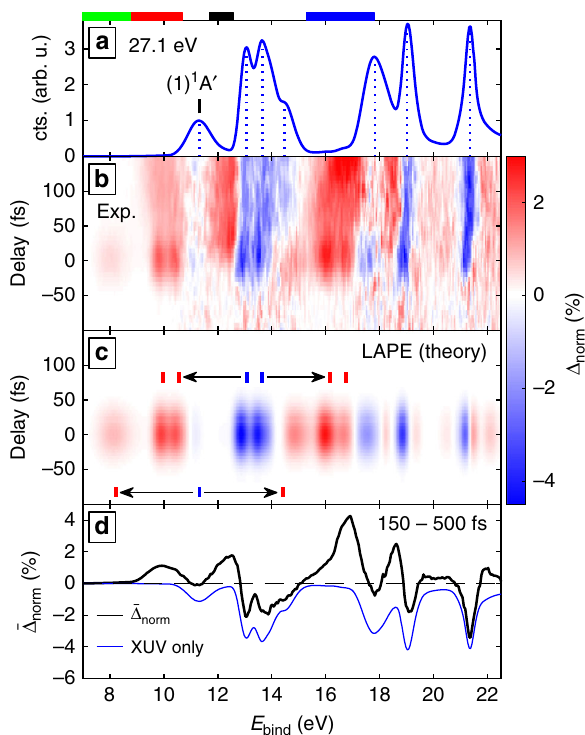
Fig. 3 Description of the data analysis and laser-assisted photoelectric effect (LAPE). a Experimental photoelectron spectrum of unexcited NO 2 obtained with an XUV photon energy of 27.1 eV. The dashed blue lines indicate the peak position of each band. The color bars label the energy domains that are analyzed further in Figs. 4 and 5 ( b ) Experimental difference spectrum showing the excited-state photoelectron bands in red (gain) and depletion of XUV-only peaks (blue). The colormap is given in percent of the (1) 1 A ′ peak in the XUV-only spectrum. The time convention is that for negative times the XUV pulse comes fi rst. c Calculated LAPE spectrum (see text). The arrows indicate which photoelectron band (blue dashes) is shifted to which fi nal position by the energy of one UV photon (3.1 eV) (red dashes). d Difference spectrum averaged over the delay range from 150 to 500 fs. An XUV-only spectrum is shown in the same plot in order to highlight depletion dominated